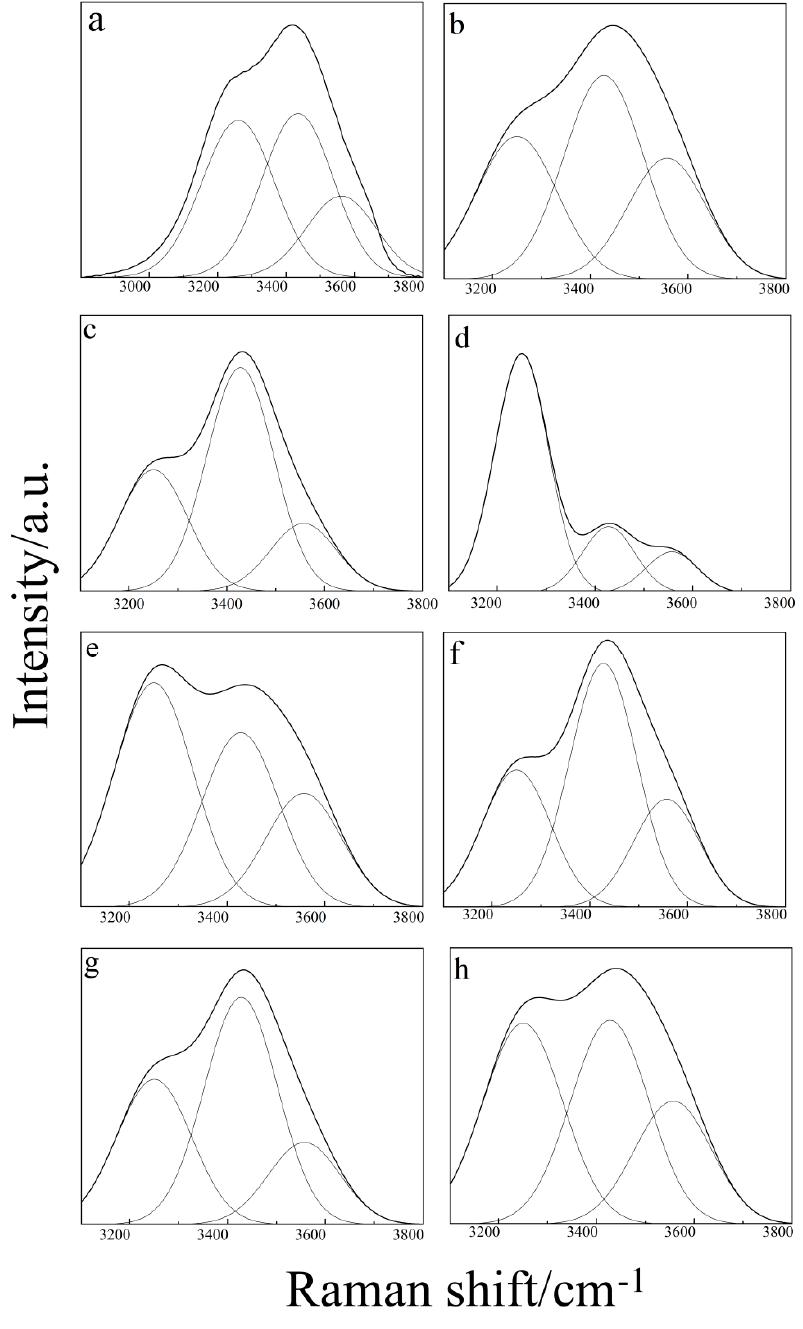
Figure 5. Deconvolution of Raman spectra into three Gaussian components C1, C2 and C3 with the central wave number at 3245, 3420 and 3550 cm − 1 , for ( a ) sample a, ( b ) sample d, ( c ) sample e, ( d ) sample g, ( e ) sample h, ( f ) sample j, ( g ) sample k, and ( h ) sample m. The thicker dashed lines represent the smoothed line of the raw spectral data by the Peak Fit software. The superposed contour is the fitted line by the three Gaussian components.